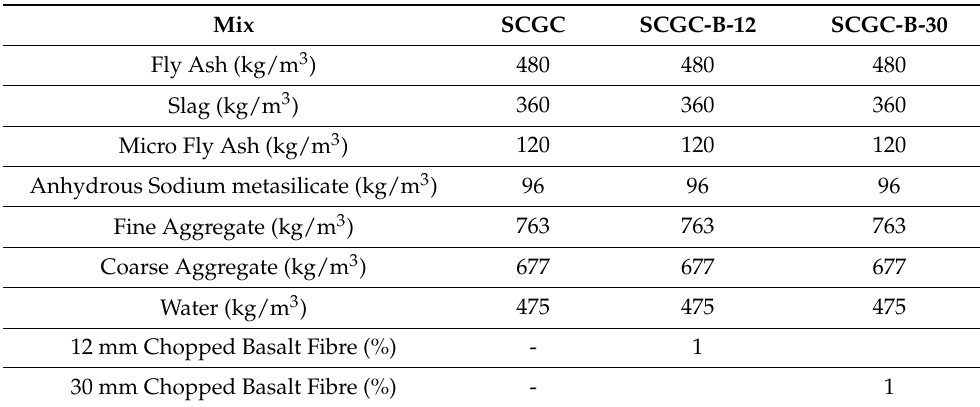
Table 2. Mix Proportions used in the study.